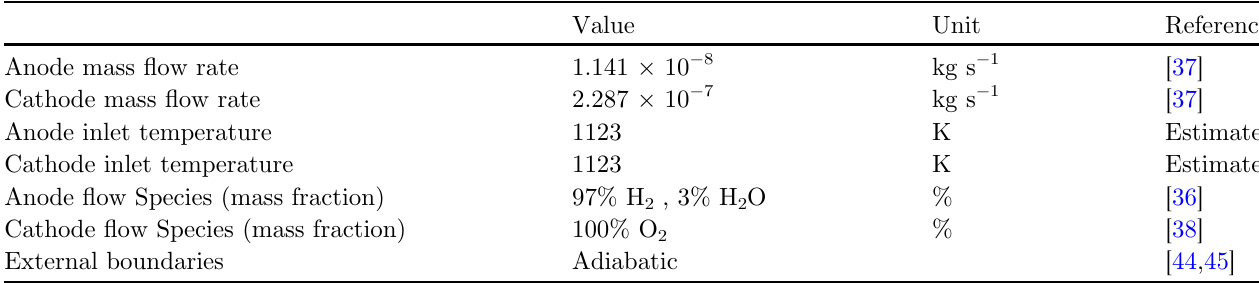
Table 4. Inlet boundary conditions for the anode and cathode